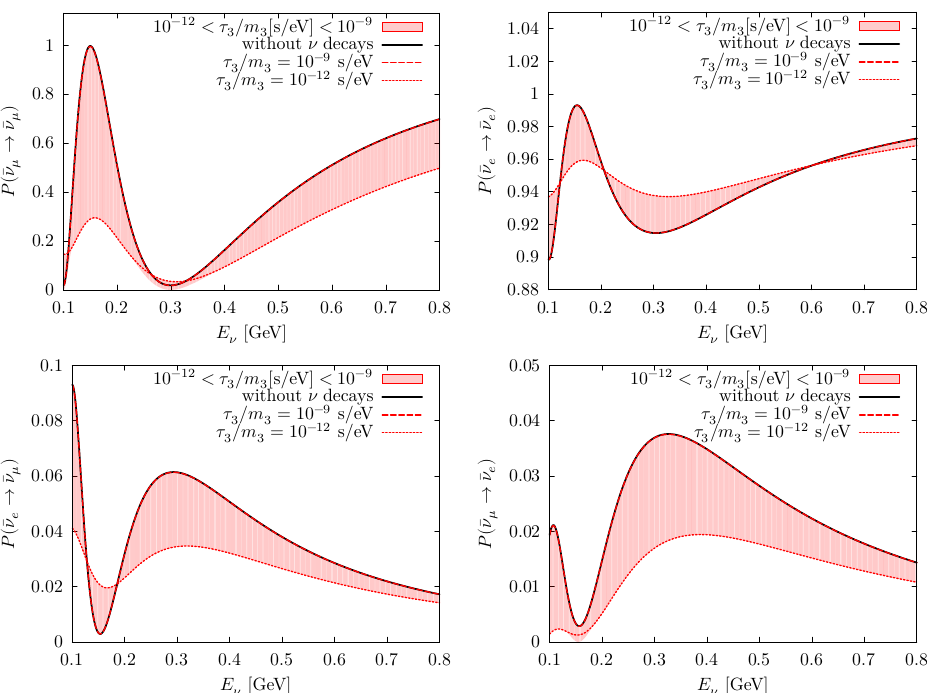
Figure 2 . The oscillation probabilities within 10 (cid:0) 12 s/eV < (cid:28) 3 =m 3 < 10 (cid:0) 9 s/eV (red band) for MOMENT. We especially present the probability with (cid:28) 3 =m 3 = 10 (cid:0) 12 s/eV (red-dotted curve), = 10 (cid:0) 9 s/eV (red-dashed curve) and = 1 (black curve). Four channels are considered: (cid:22) (cid:23) (cid:22) ! (cid:22) (cid:23) (cid:22) (upper-left), (cid:22) (cid:23) e ! (cid:22) (cid:23) e (upper-right), (cid:22) (cid:23) e ! (cid:22) (cid:23) (cid:22) (right-left), and (cid:22) (cid:23) (cid:22) ! (cid:22) (cid:23) e (lower-right). The following oscillation parameters are used: (cid:18) 12 =33 : 8 (cid:14) , (cid:18) 13 =8 : 61 (cid:14) , (cid:18) 23 =49 : 6 (cid:14) , (cid:1) m 2 (cid:1) m 2 =2.52 (cid:2) 10 (cid:0) 3 eV 2 , and (cid:14) = 270 (cid:14) 31